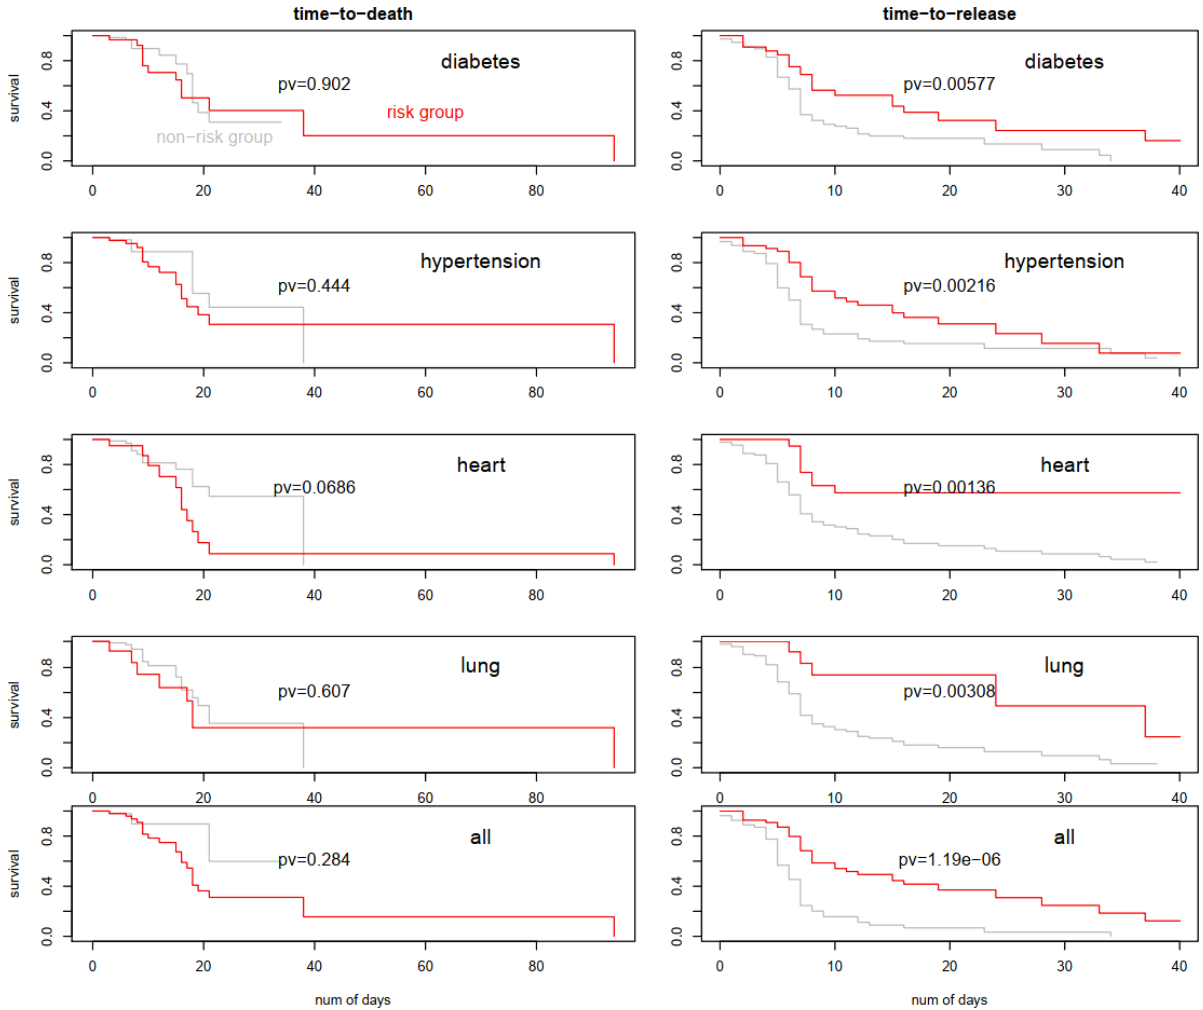
Figure 2. Comparison between the survival curves from time-to-death (left) and those from time-to-release (right) with 4 different comorbidities and the indicating variable for any one of these conditions. Red lines are for those with a comorbidity and grey lines are for those who do not have a comorbidity condition. “Heart” refers to ischemic heart disease, “lung” refers to obstructive pulmonary disease, and “all” refers to the presence of any one of the four comorbidity